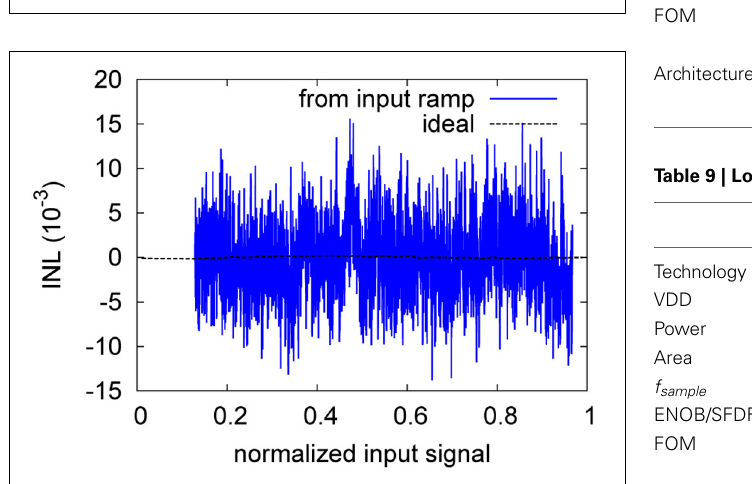
FIGURE 13 | Ideal and ramp-based INL of the neuron perturbation of Table 6.